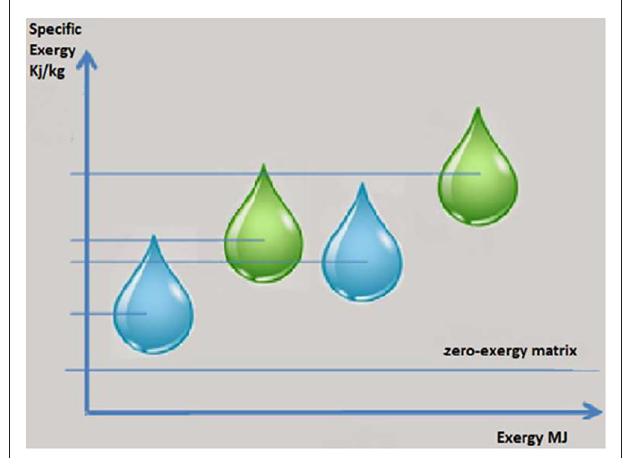
FIGURE 1 | A qualitative description of some reservoirs in the thermoeconomic